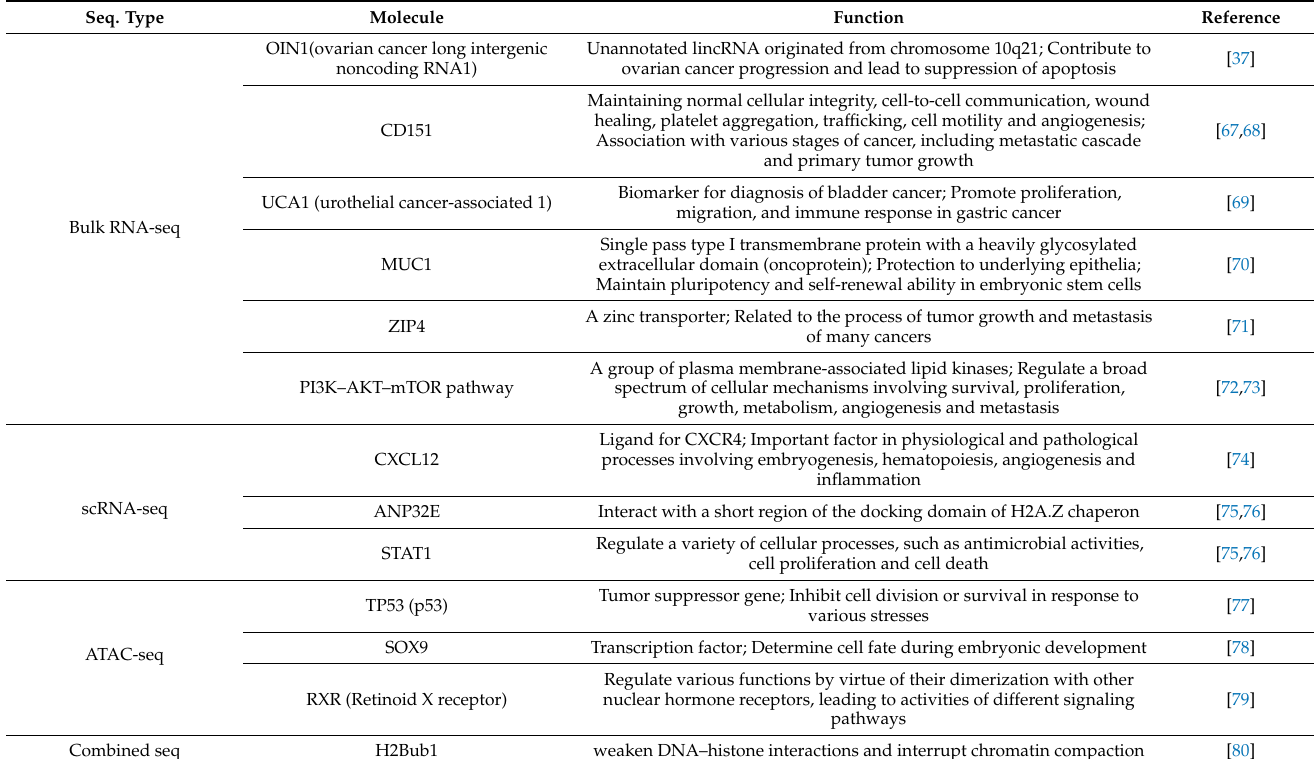
Table 1. Molecular targets discovered through NGS in ovarian